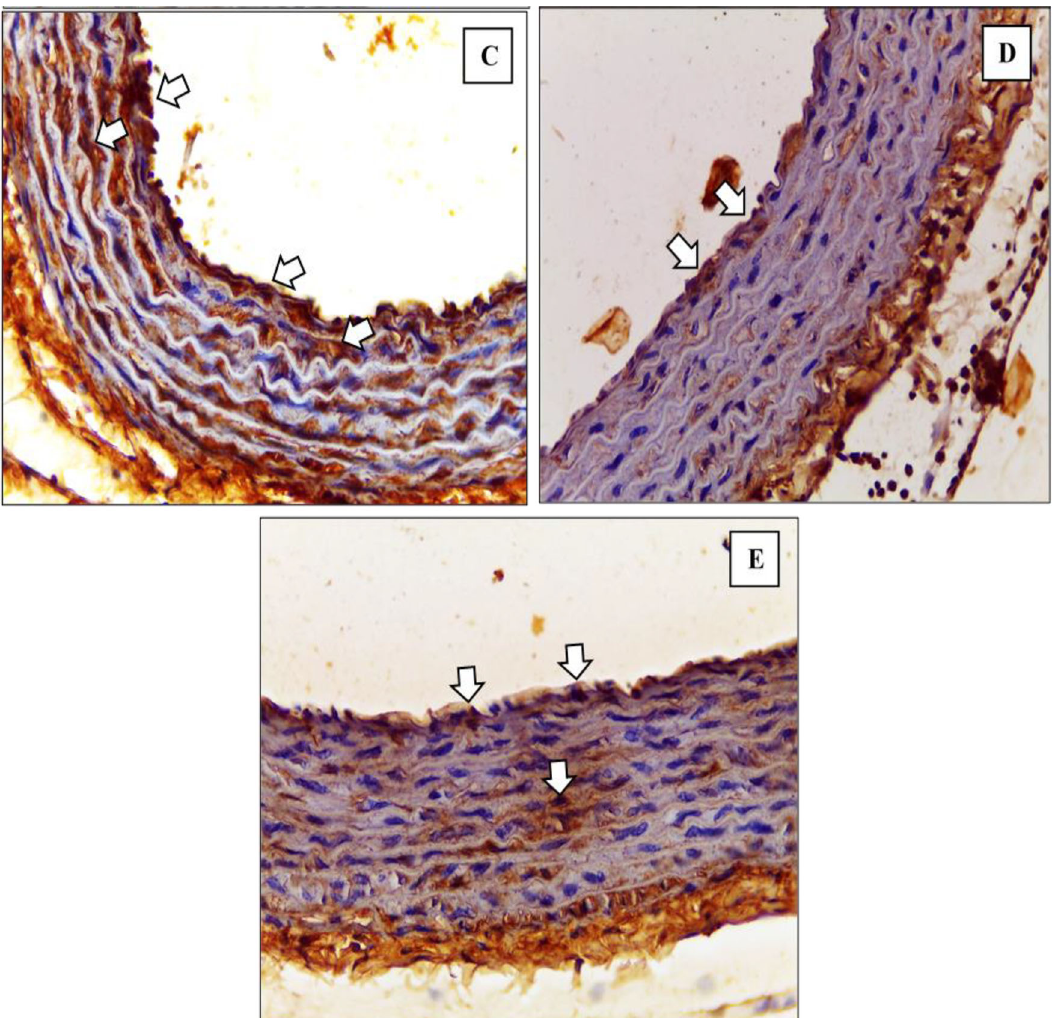
Figure 5. Immunohistochemical staining of M1 expression by CD38 (white arrow) on (C) P1 (D) P2 ( E)